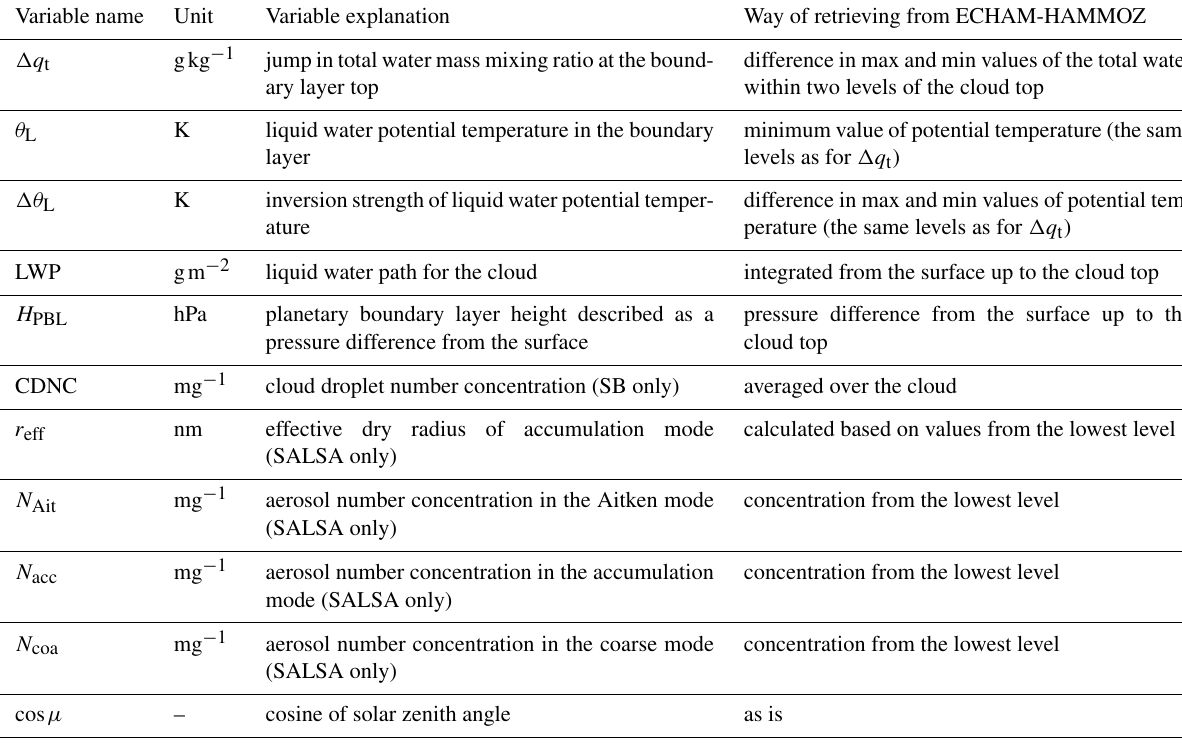
Table 1. Variables retrieved from ECHAM-HAMMOZ.